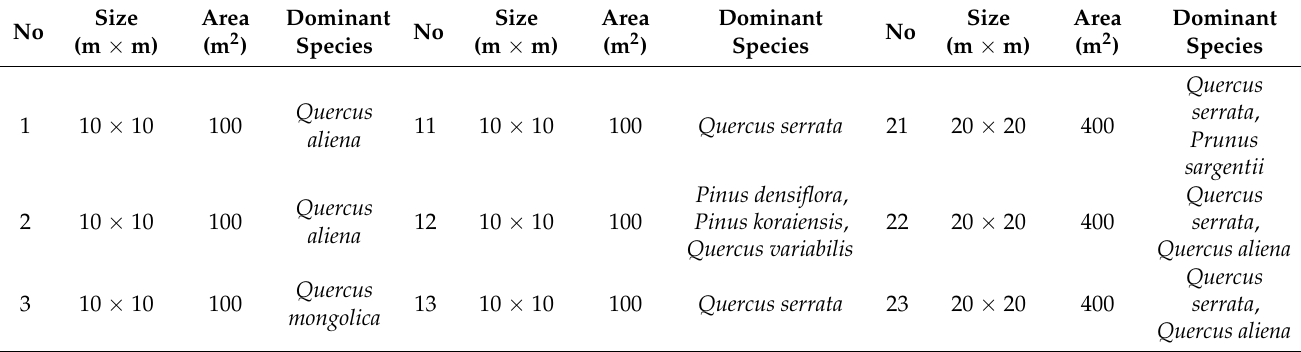
Table 1. Fixed survey plots in the forest of the Changdeokgung Rear